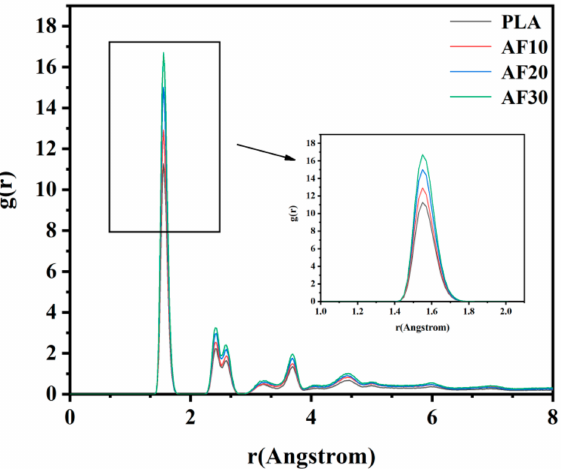
Figure 7. Radial distribution function of the intra-molecular carbon–carbon pairs of PLA, AF10, AF20, and AF30.